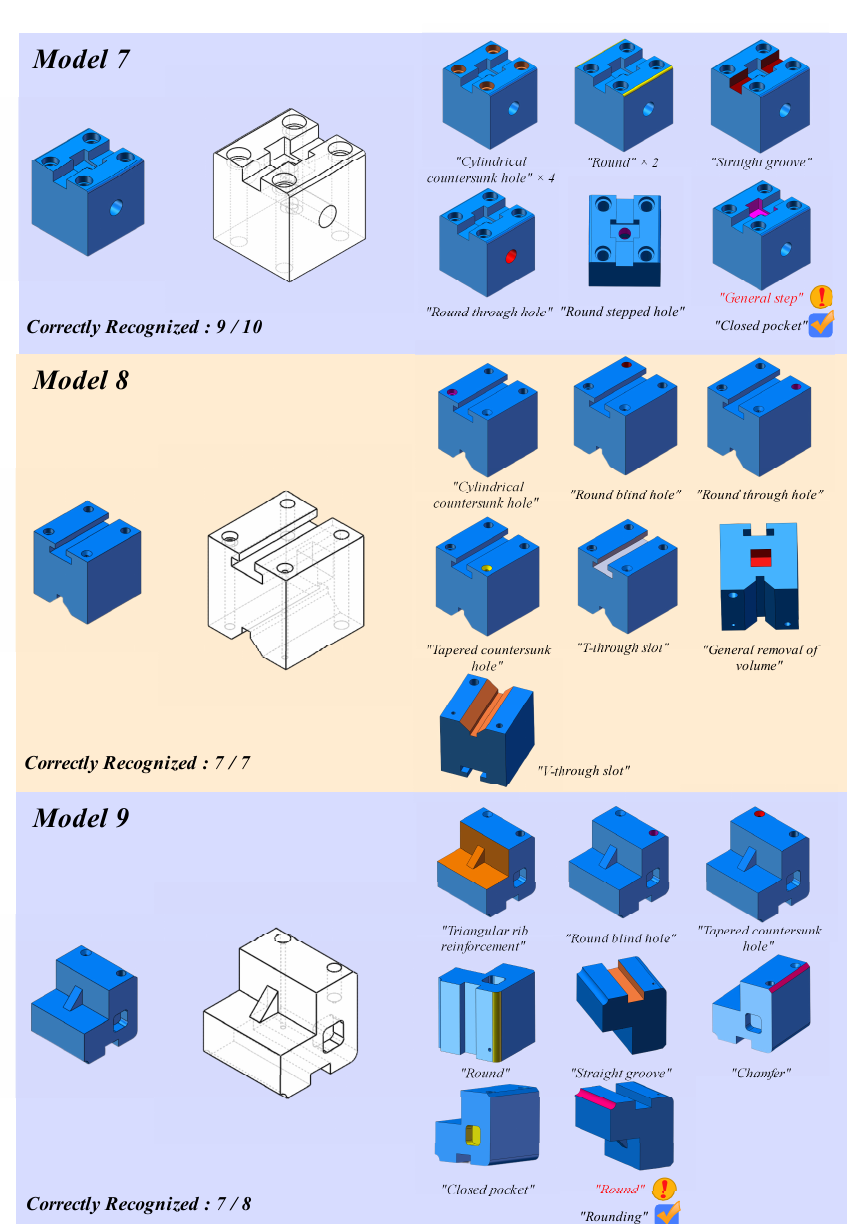
Figure 10. Multi-machining feature recognition results on three complex 3D CAD models. For every model, the correctly recognized result equals the true feature types divided by the segment-identified number. The different colors of each model represent the various segment recognition